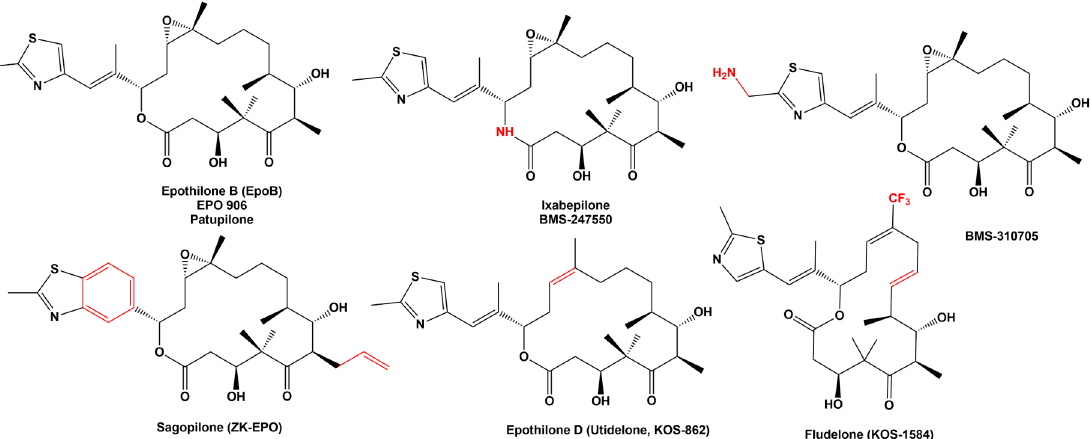
Figure 2. Structure of natural and synthetic epothilone with anticancer activity clinically evaluated. In red are remarked the main differences with EpoB.